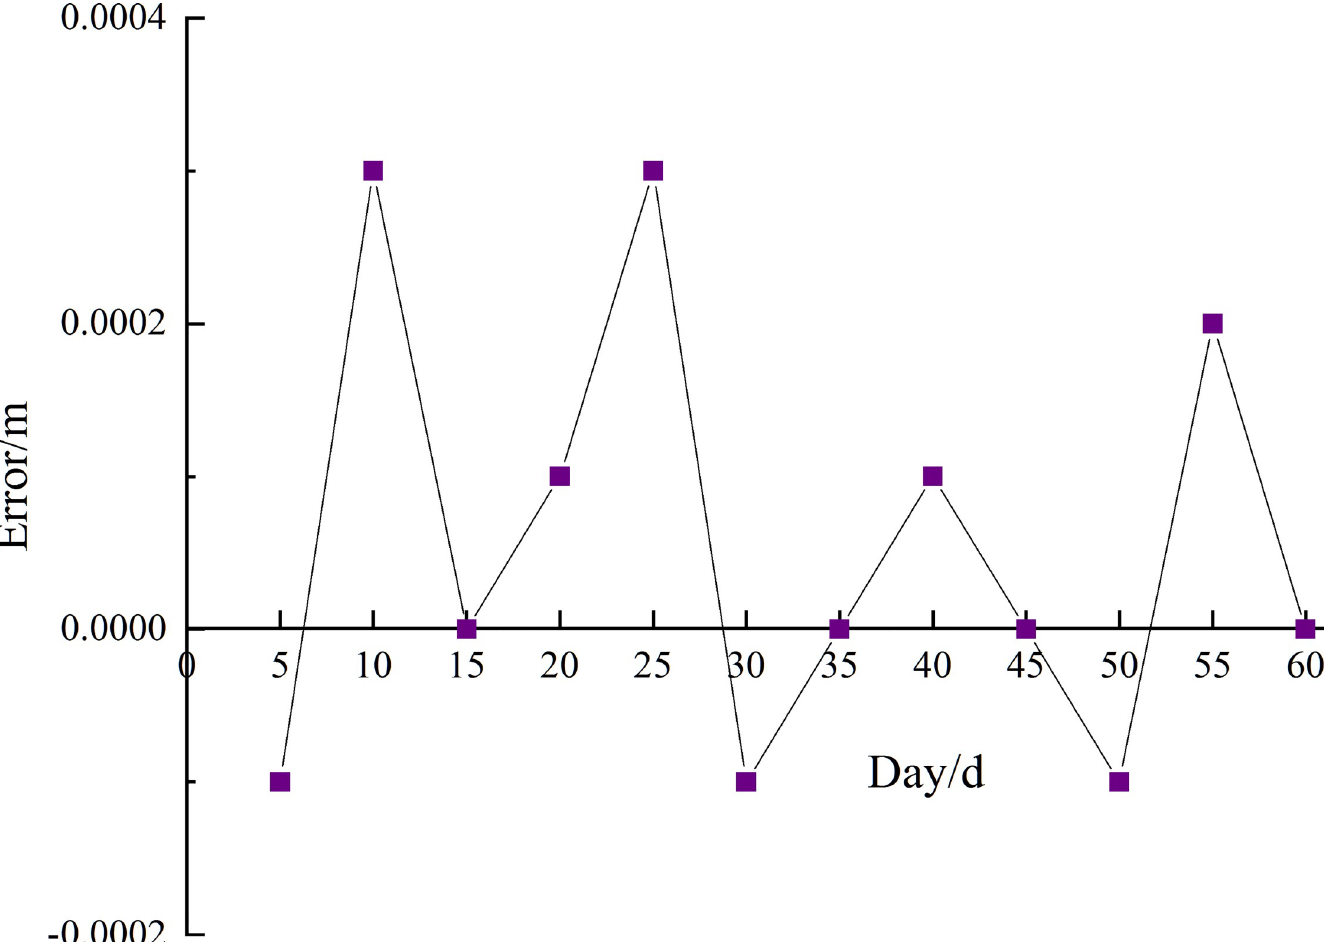
Fig 18. Changes in positioning accuracy for a separation of positioning base stations of 70 m on different days.